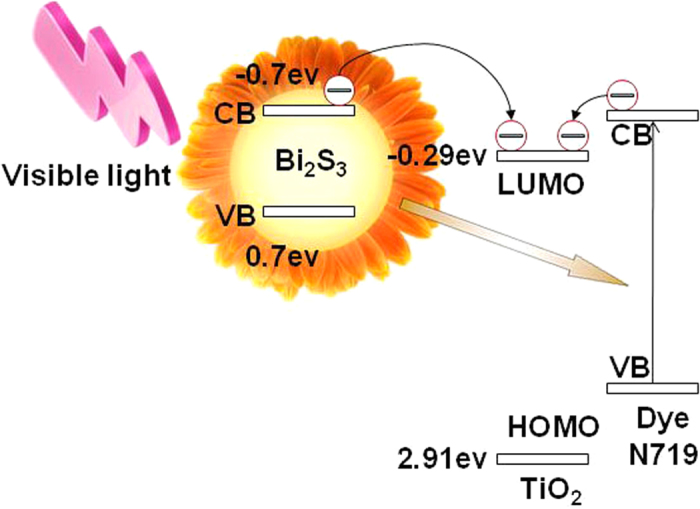
Mechanism of visible light harvesting in TiO2-Bi2S3:Eu3+ cells.